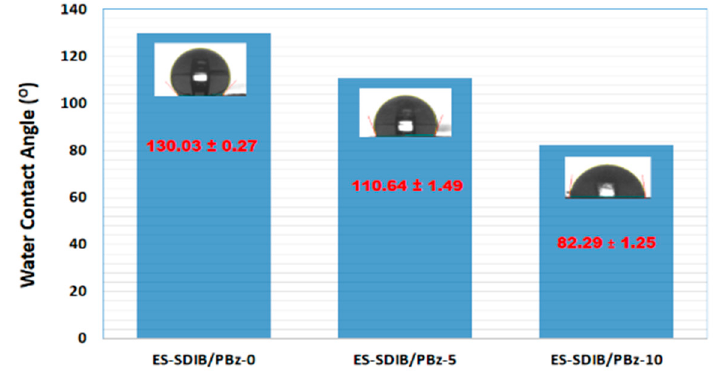
Figure 11. Water contact angles of ES-SDIB / PBz-0, ES-SDIB / PBz-5 and ES-SDIB / PBz-10. Values plotted are means ± standard deviations with three replicates taken per data point.